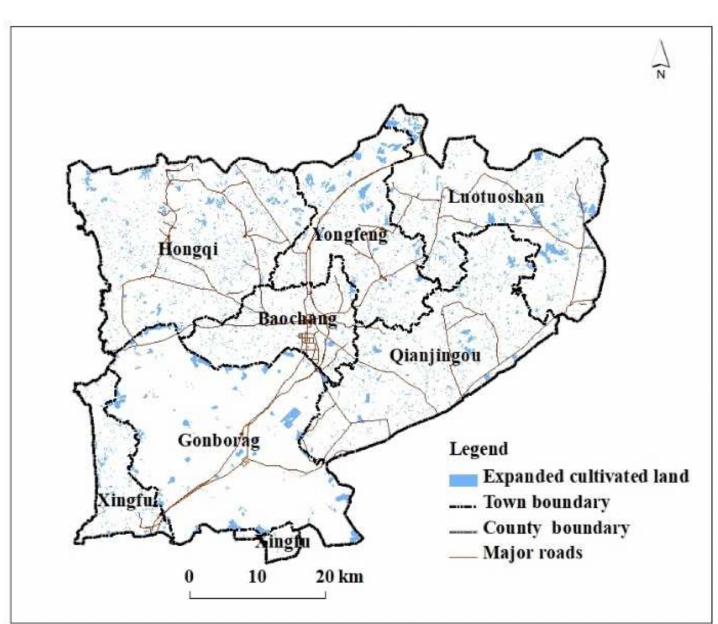
Figure 5. The distribution of the expanded cultivated land from 2010 to